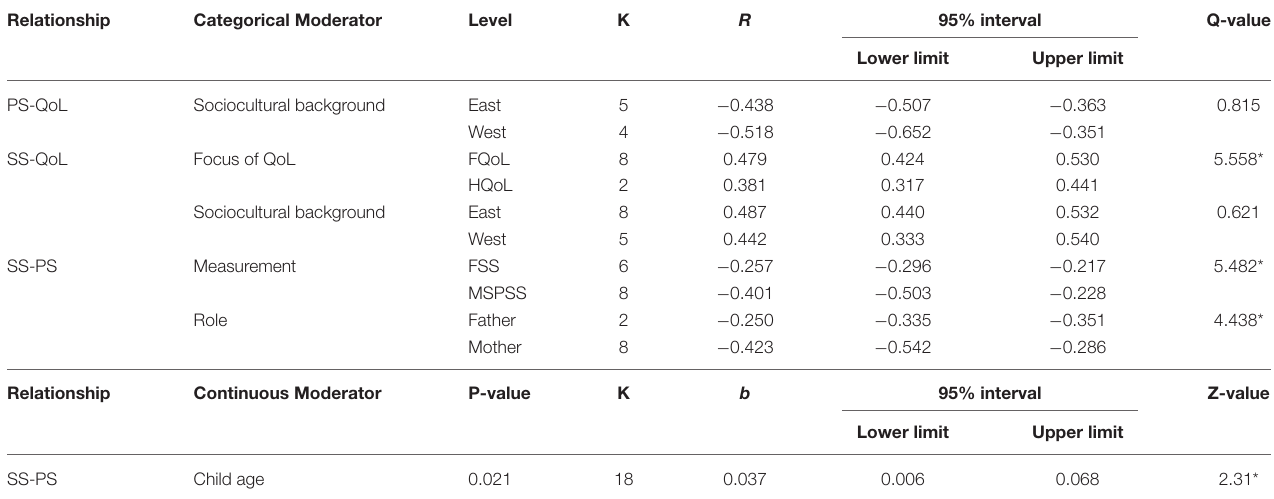
TABLE 4 | Analysis of moderation.